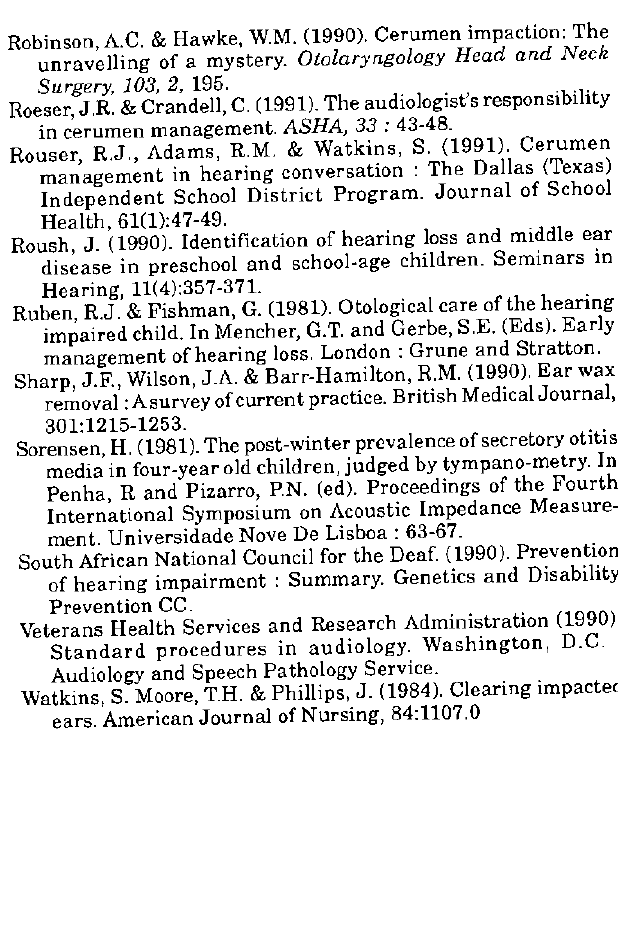
TABLE 1 rReferral Criteria : Middle Ear Screening Protocol